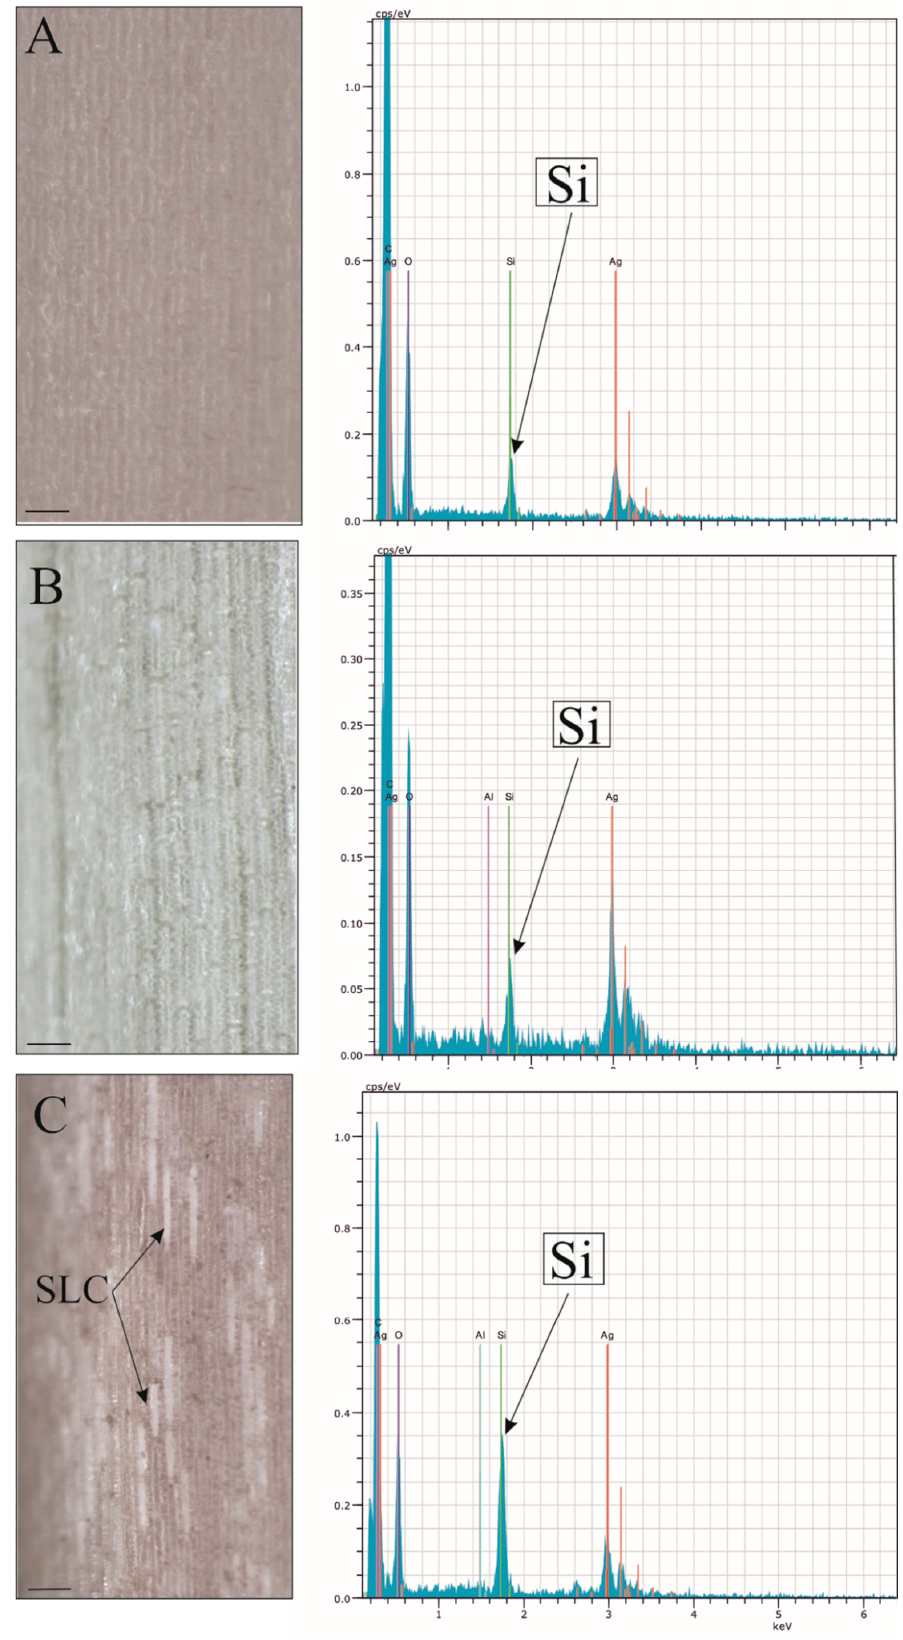
Figure 10. Stereomicroscopic pictures of the abaxial leaf surfaces: ( A ) F. vaginata ( B ) F. pseudovaginata ( C ) F. tomanii , with the EDX element spectrum diagrams near them. SLC: silicified long cells in the epidermis of F. tomanii . The line represents 50 µ